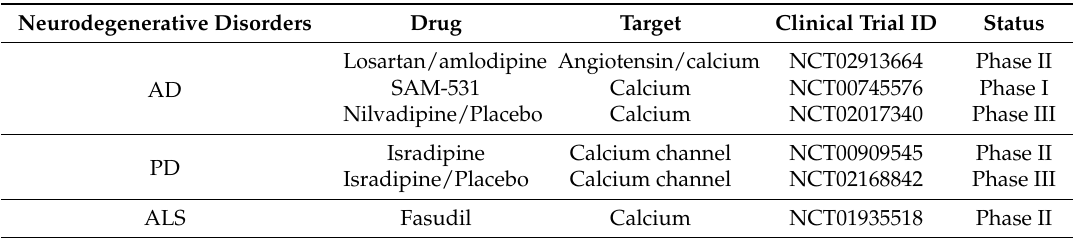
Table 1. Calcium/calcium channel antagonist is now used in clinical trials for neurodegenerative diseases